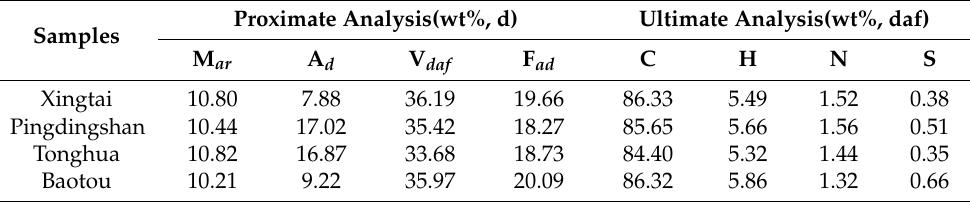
Table 1. The physical and chemical properties of coking coal.